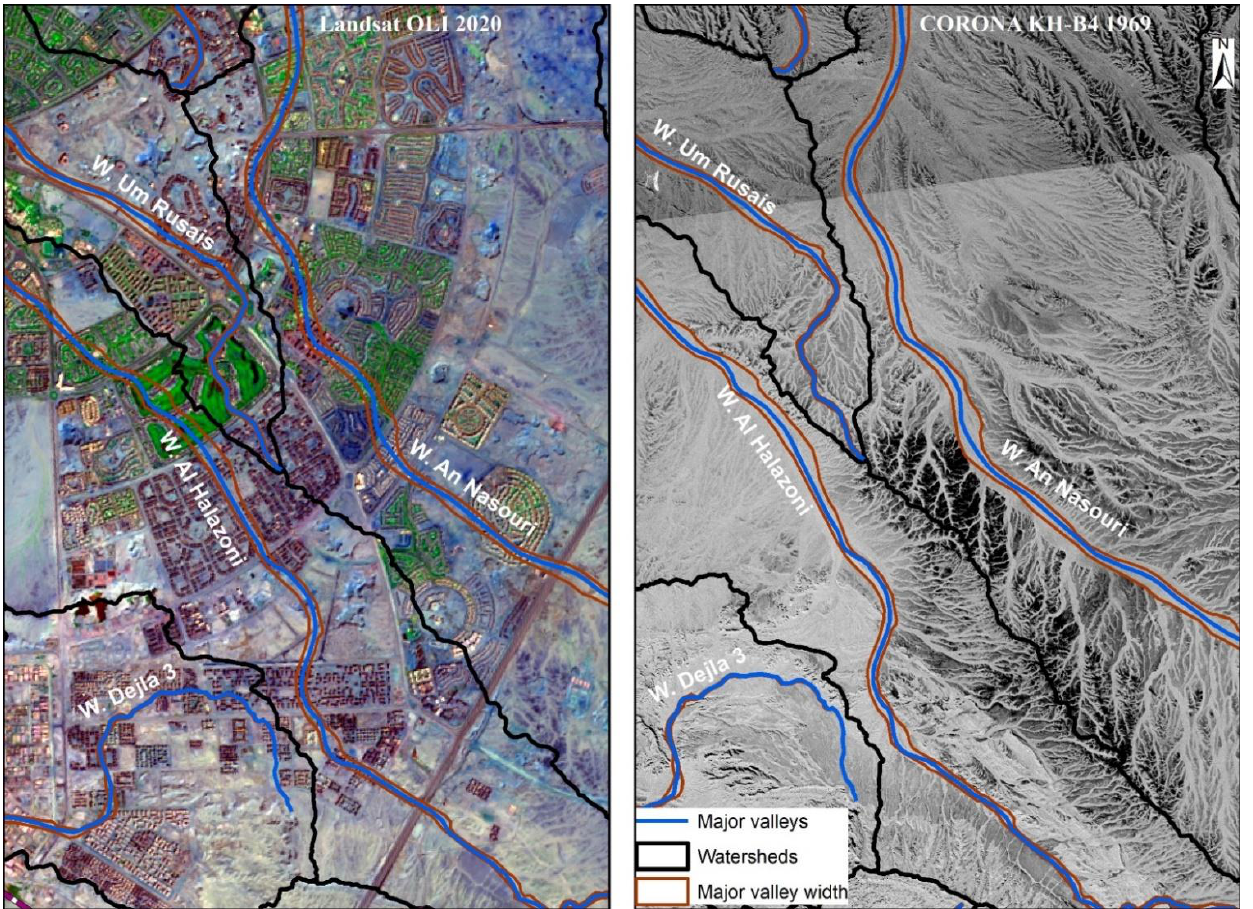
Figure 14. The aggression of urban spatial expansion against the valley floors as demonstrated by the comparison between CORONA and Landsat OLI images acquired in 1969 and 2020, respec- tively.